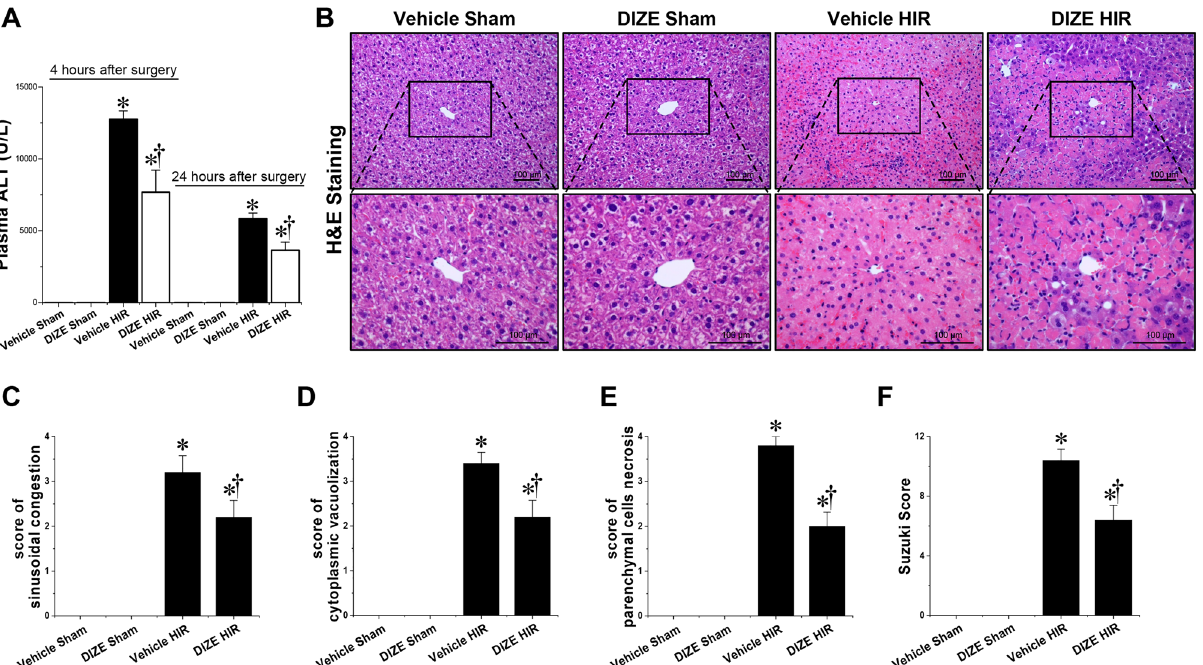
Figure 1. Effect of DIZE on liver injury following hepatic ischemia/reperfusion. C57BL/6 male mice were subjected to partial hepatic ischemia (HIR) induction for 1 h or sham surgery. Mice were randomized to receive treatment with either Diminazene aceturate (DIZE) or vehicle control (saline) before undergoing surgery, as described in “Methods”. ( A ) Four and twenty-four hours after surgeries, plasma ALT levels were measured. Liver sections were subjected to hematoxylin and eosin (H&E) staining ( B , Upper panel: magnification X200; lower panel: magnification X400) and histological damages ( C , D , E , and F ) were analyzed using Suzuki’s criteria (sinusoidal congestion, parenchymal cell necrosis and cytoplasmic vacuolization). Results are expressed as mean ± SEM (n = 5). For statistical analysis, the one-way ANOVA plus Tukey’s post hoc multiple comparison test was used to detect significant changes in plasma ALT levels and the Mann–Whitney nonparametric test and t test were used to detect significant changes of Suzuki score with Origin 2021 v.9.8.0 200 (OriginLab, https:// www. origi nlab. com) software. *P < 0.05 vs. Vehicle Sham, †P < 0.05 vs. Vehicle